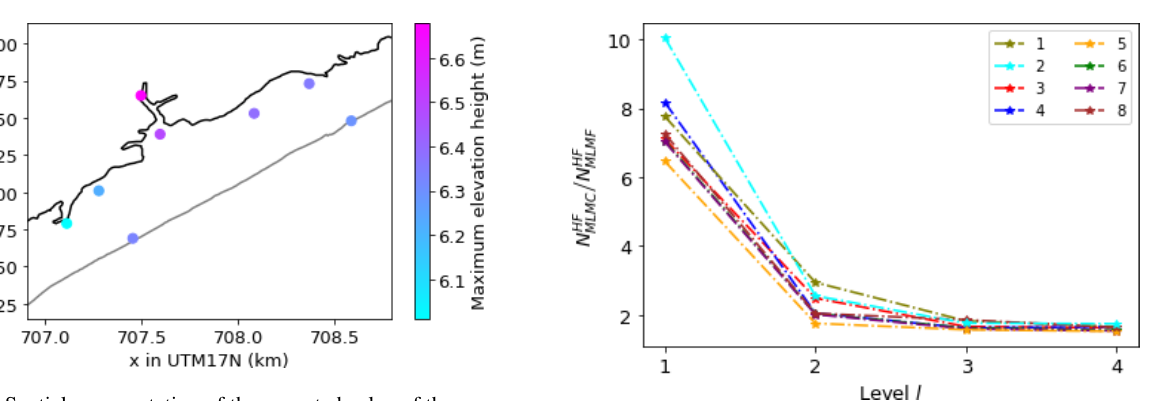
Figure 28. Spatial representation of the expected value of the max- imum elevation height estimated using MLMF with a tolerance of (cid:15) = 3 × 10 − 2 in Eq. (14).